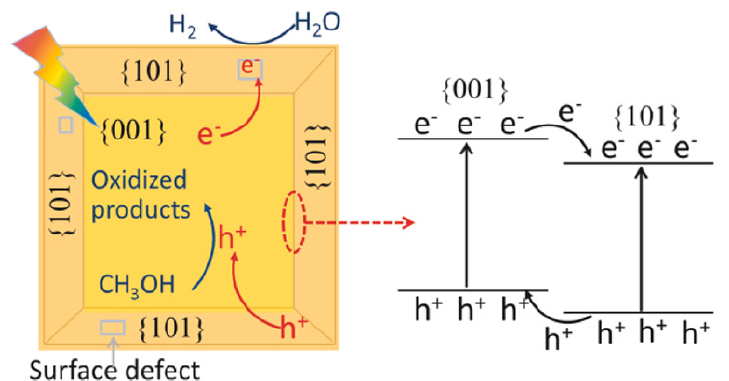
Figure 12. Photocatalytic reaction mechanism of photocatalytic H 2 generation in methanol/water solution over self-doped anatase nanosheets with exposed {101} and {001} facets. Reprinted with permission from [111]. Copyright 2021, Elsevier.